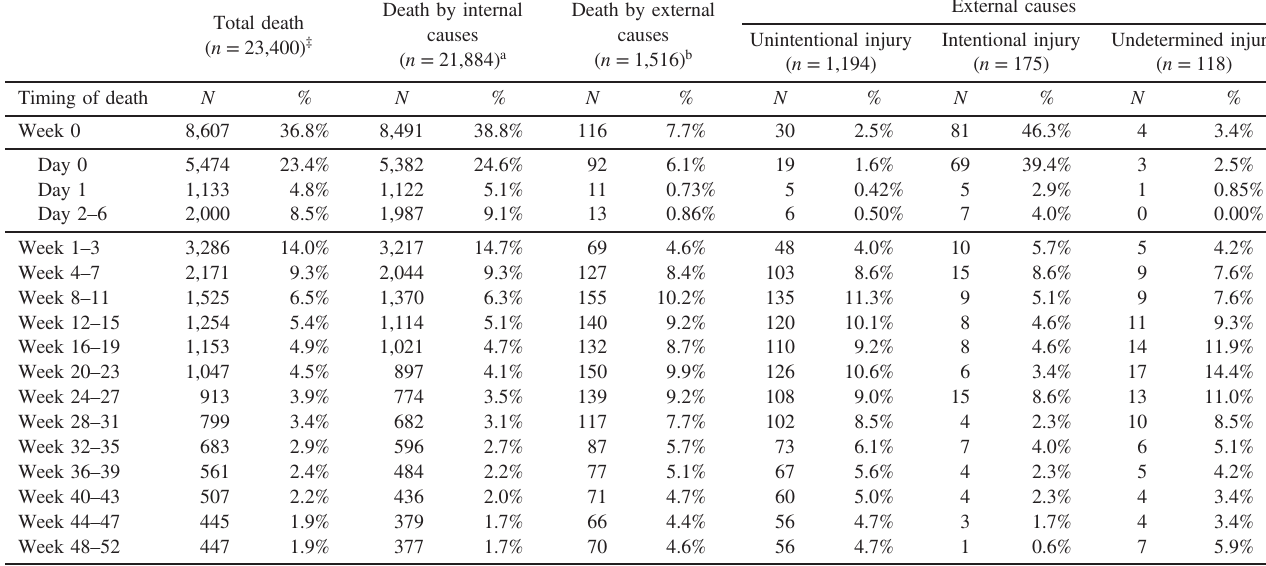
Table 3. Infant deaths by age and causes: analysis of 23,400 infants among those born from 2003 –